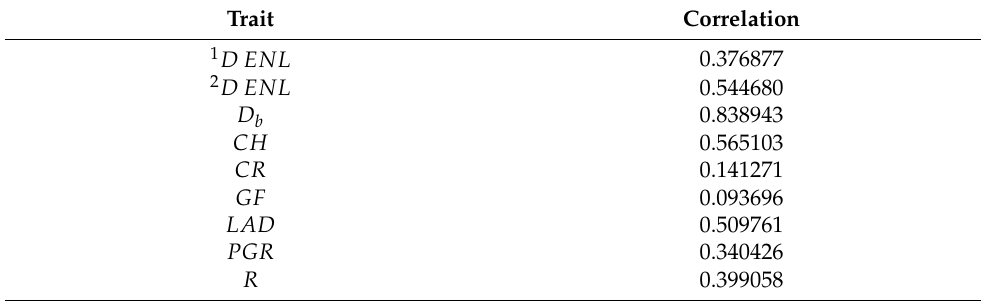
Table A15. Overview of correlation between ULS and TLS traits at 5m grid size.